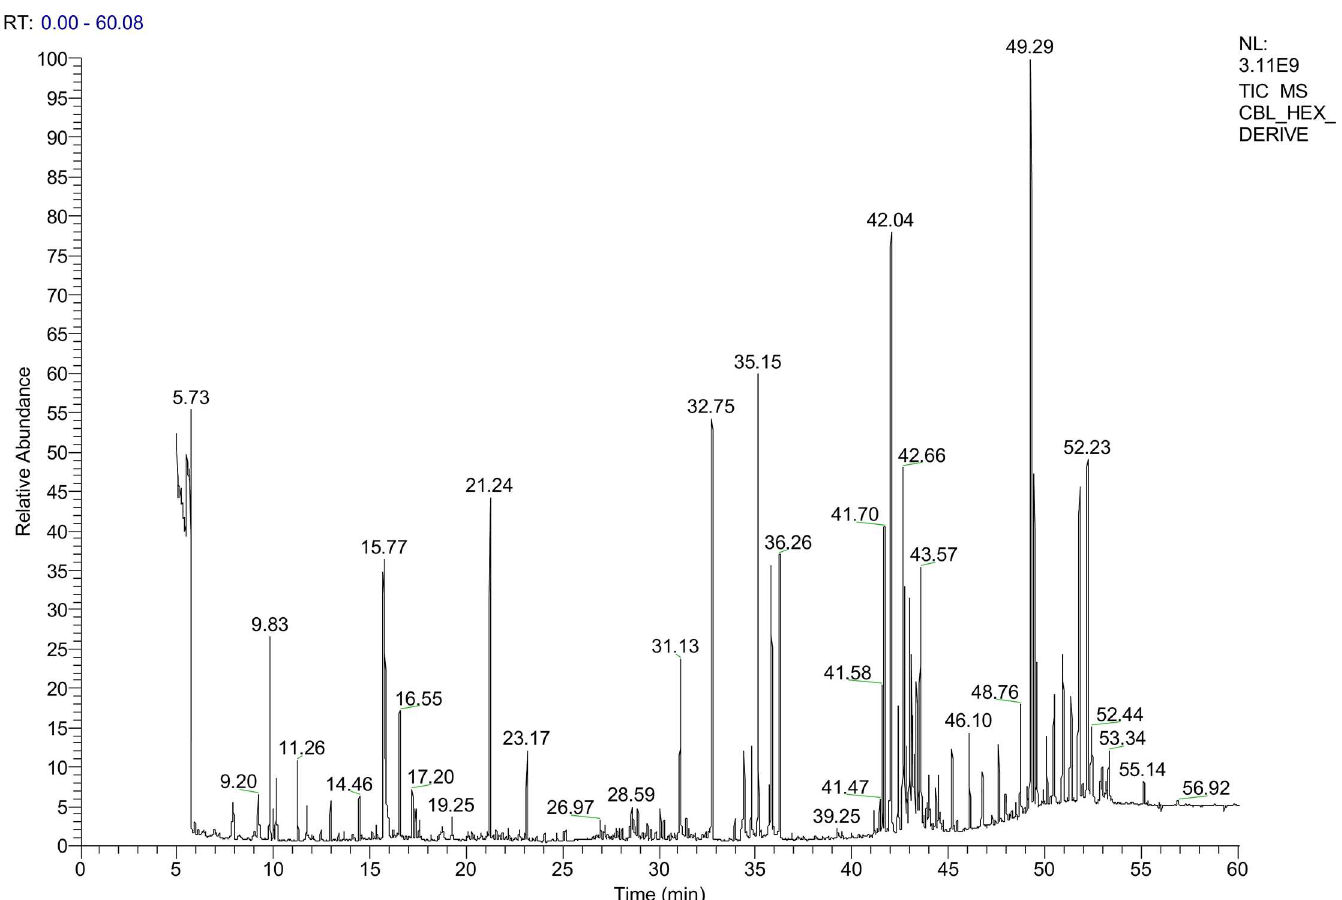
Fig 12. Gas Chromatography Mass Spectrometry (GC-MS) analysis of Croton bonplandianus .